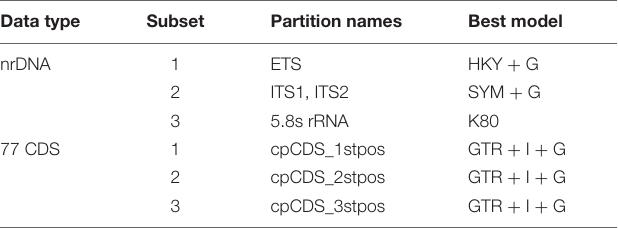
TABLE 1 | Best partitioning scheme and nucleotide substitution models for nrDNA and 77 CDS data determined by PartitionFinder